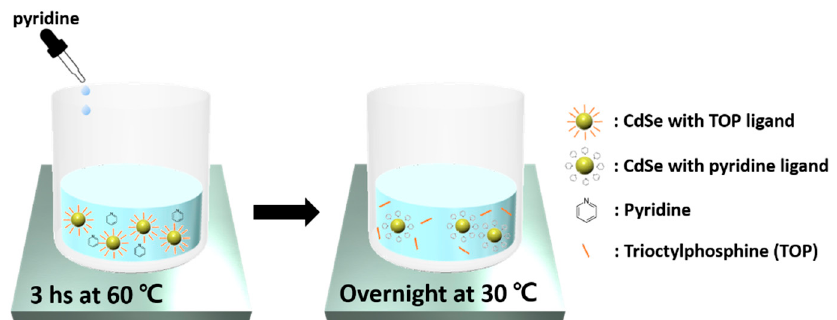
Figure 7. Ligand exchange sequence substituted with pyridine.